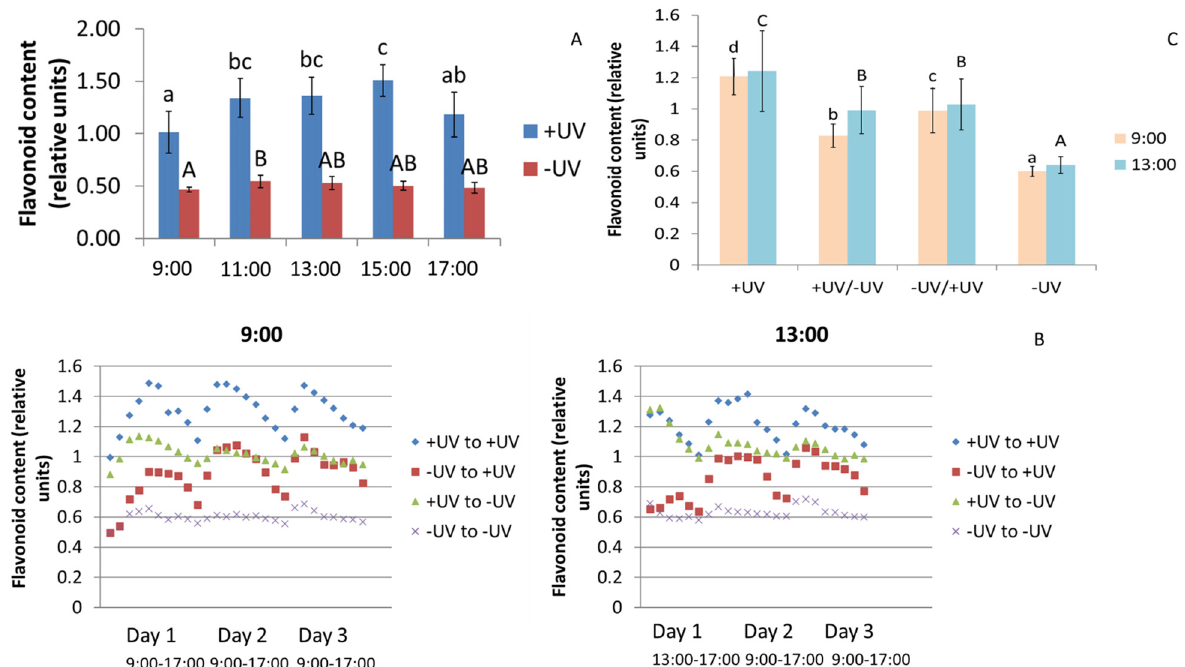
Figure 1. Flavonoid contents measured optically (Dualex) in okra plants ( A ) in a one-day diurnal rhythm (Experiment 1— targeting diurnal rhythm) and ( B ) a follow-up for three days after a transfer of okra plants at 9:00 and 13:00 (Experiment 2—targeting changes in diurnal rhythm due to transfer to the opposite UV condition) and ( C ) after an adaptation for seven days at 9:00 and 13:00 (Experiment 2—targeting changes in diurnal rhythm due to transfer to the opposite UV condition). Different letters represent significant differences at p ≤ 0.05. Table 2. Soluble flavonoid glycosides and hydroxycinnamic acids in okra grown under different UV conditions at different times of the day in Experiment 1 (targeting diurnal rhythm). Different letters represent significant differences between the times of a day at p ≤ 0.05. I: isorhamnetin; K: kaempferol; Q: quercetin; glc: glucose; xyl: xylose; HFer: hydroxyferuloly; Sin: sinapoyl.